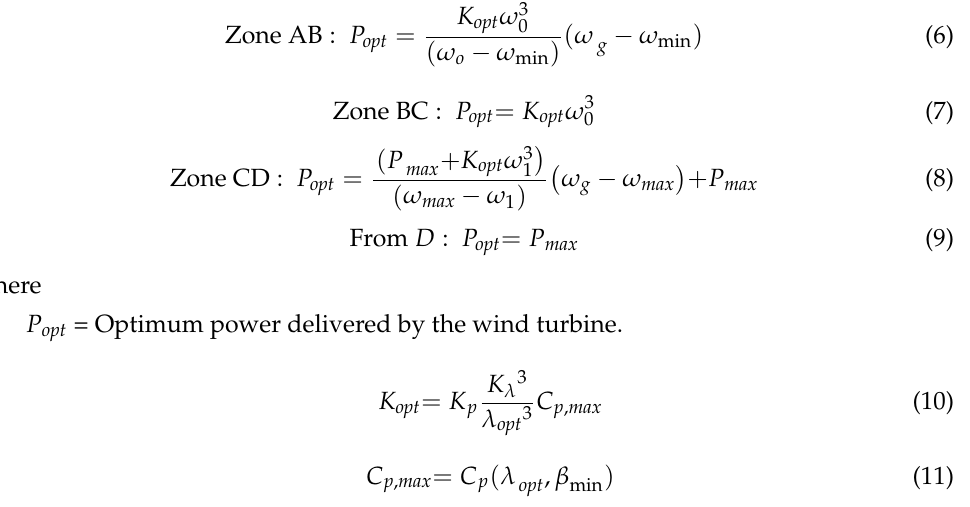
Figure 6. Maximum power point tracking curve for the wind turbine model MADE AE-59.